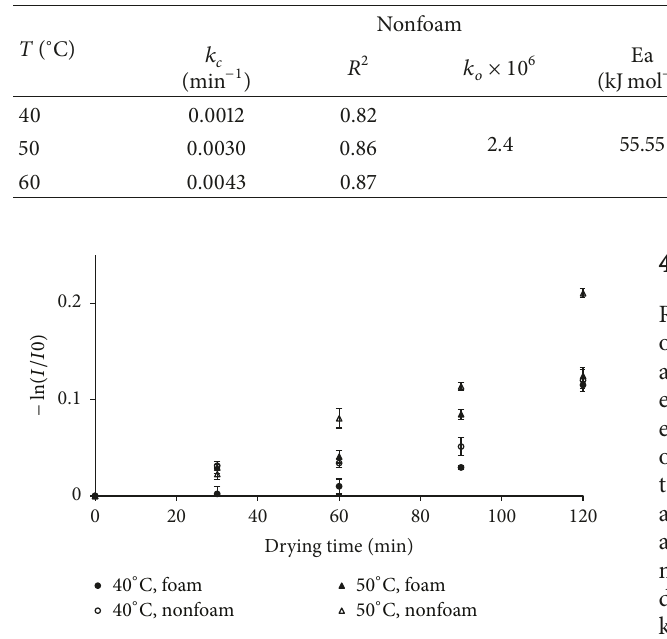
Figure 4: The antioxidant activity degradation at various drying conditions.